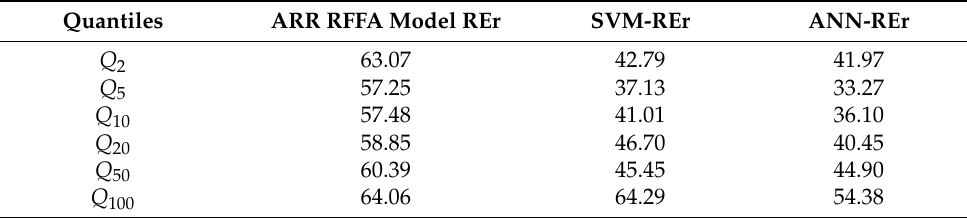
Table 4. Comparison of the REr values between the ARR RFFA, SVM and ANN